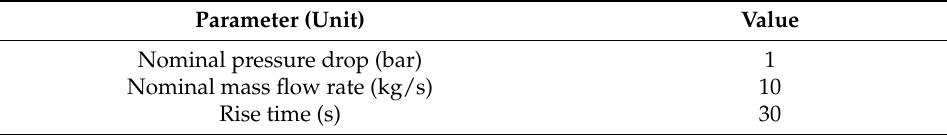
Table 2. Parameterization of the steam conditioning valves.